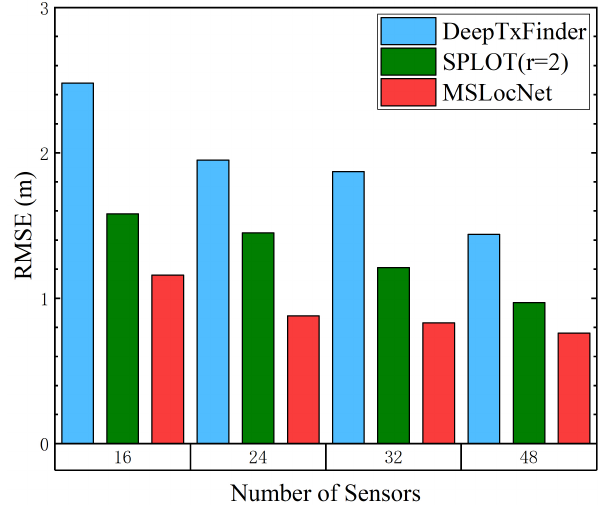
Figure 9. The RMSE (m) for real